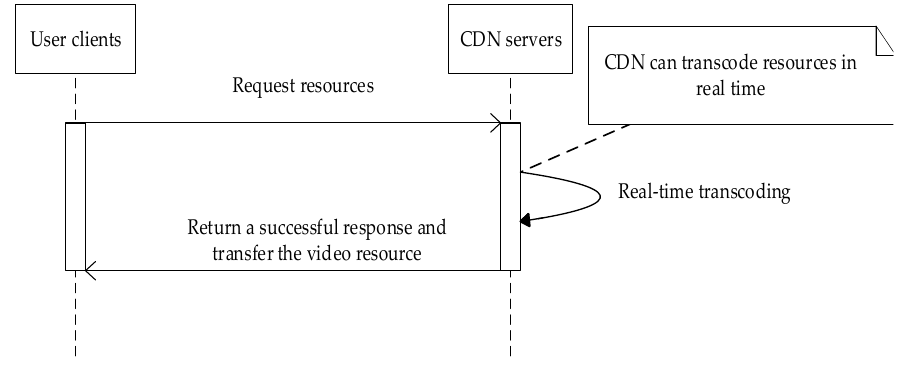
Figure 3. Sequence diagrams of CDN direct storage of video format.